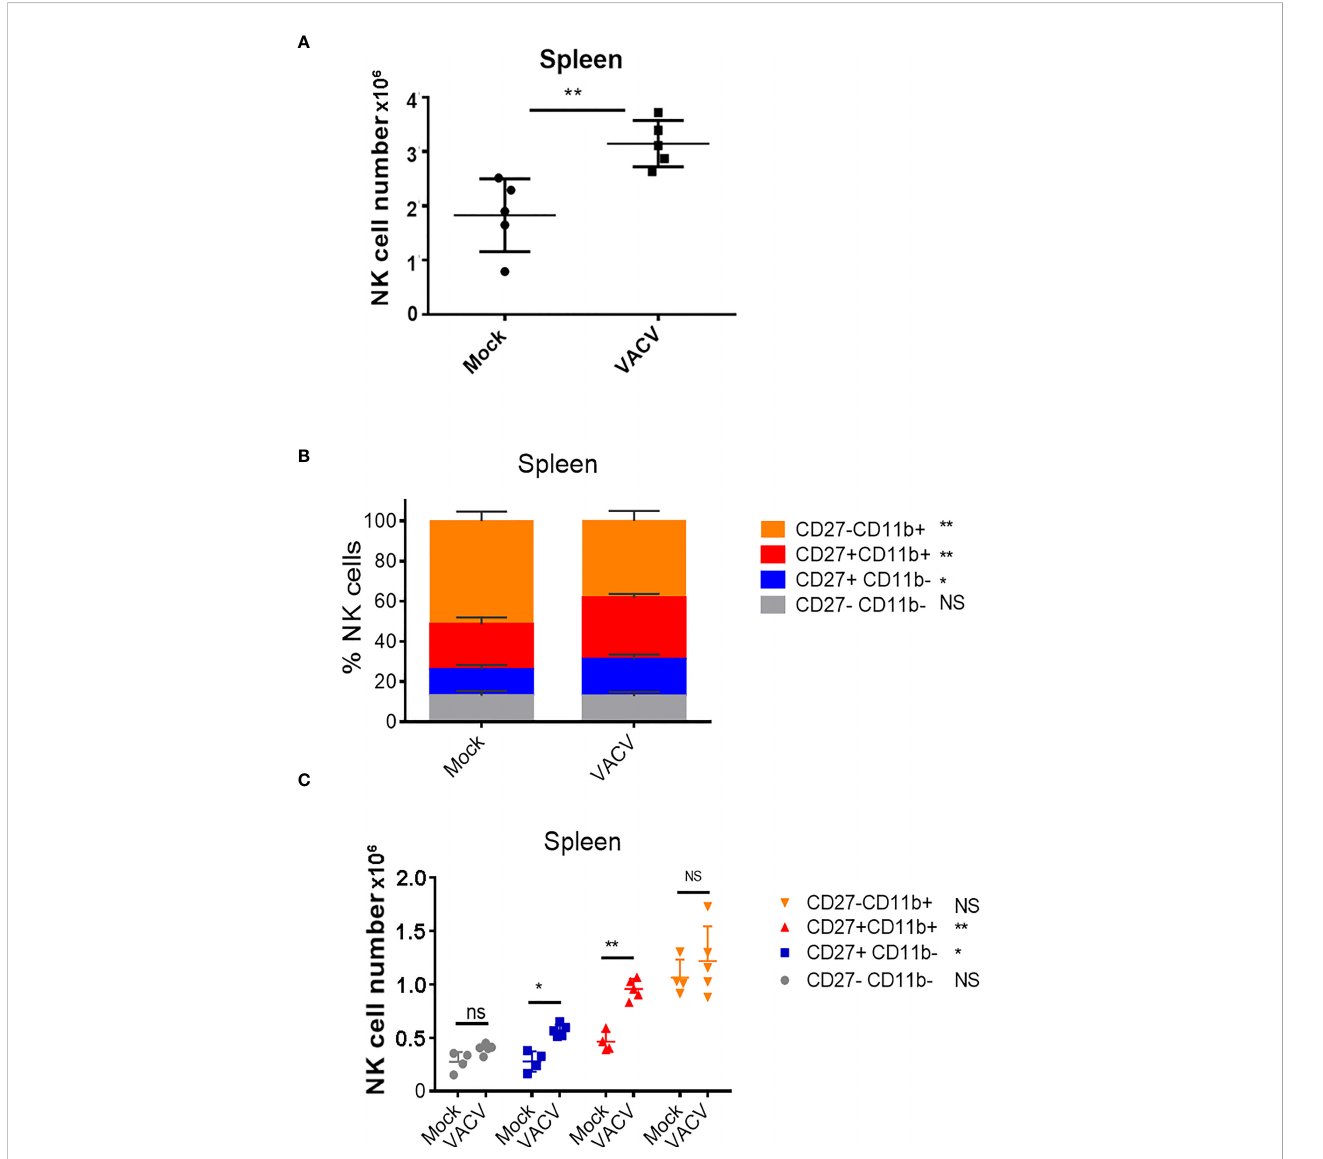
FIGURE 1 Expansion and maturation of splenic NK cells in response to VACV infection. C57BL/6 mice were mock-treated or infected i.n. with VACV and 6.5 d later (A) splenic NK cells were counted. (B, C) splenic NK subsets were quanti fi ed by fl ow cytometry for CD27 and CD11b expression. Data presented are representative of two independent experiments n=5 *p < 0.05, **p < 0.01. NS, non-signi fi